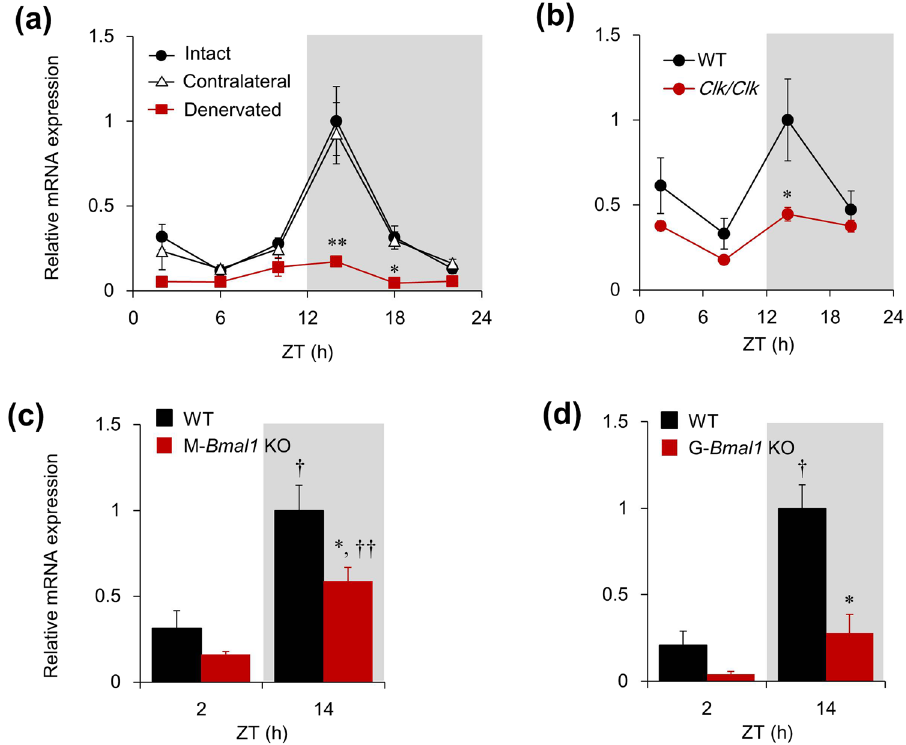
Figure 1. Slc25a25 is a circadian gene in skeletal muscle. ( a ) Circadian expression of Slc25a25 in skeletal muscle seven days after sciatic denervation. Contralateral innervated muscles of same mice and muscles of intact mice served as controls. Gray shading indicates dark period. Data are expressed as means ± SEM (n = 5–6 per group). Maximal value for intact mice is expressed as 1.0. * P < 0.05 and ** P < 0.01 for intact vs. denervated muscle at corresponding Zeitgeber time (ZT). ( b ) Temporal expression profiles of Slc25a25 mRNA in skeletal muscle of Clock mutant ( Clk/Clk ) mice. Gray shading indicates dark period. Data are expressed as means ± SEM (n = 4–5 per group). * P < 0.05 for WT vs. mutant mice at corresponding ZT. ( c , d ) Muscle-specific (M- Bmal1 KO) or global (G- Bmal1 KO) Bmal1 knockout mice. Gray shading indicates dark period. Data are expressed as means ± SEM (n = 4–5 per group). Maximal value for wild-type (WT) mice is expressed as 1.0. * P < 0.05 for WT vs. mutant mice. † P < 0.05 and †† P < 0.01 for ZT2 vs. ZT14. Supplemental Tables 2 and 3 show results of statistical